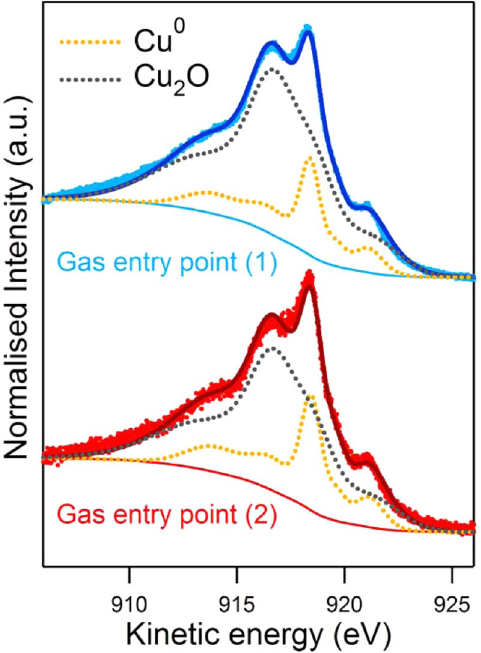
Figure 7. Comparison of the Cu LMM peak after O 2 injection through gas entry points 1 and